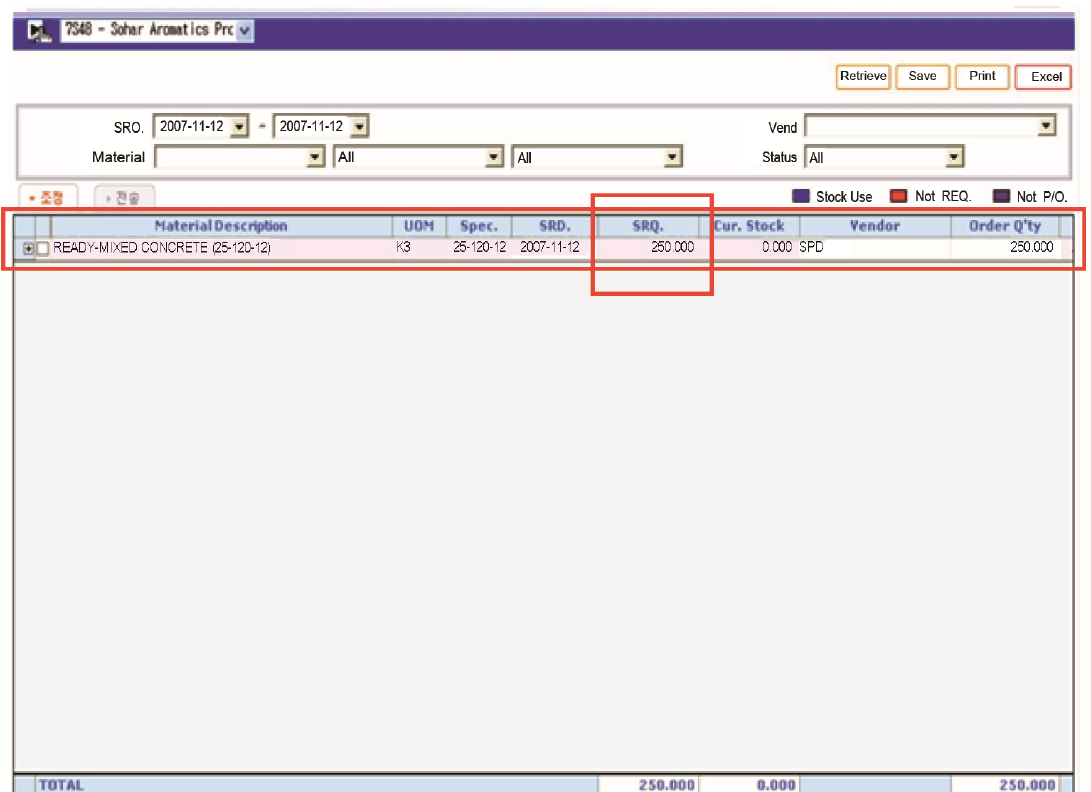
Fig. 13. Approval by the material